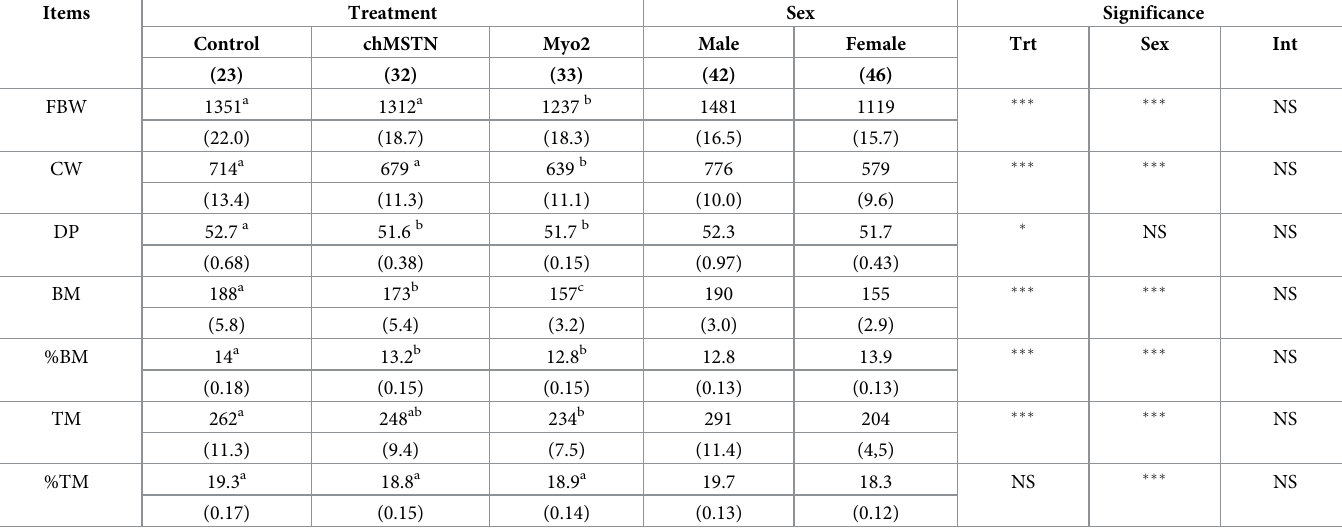
Table 4. Carcass characteristics of chicks from control, chMSTN, and Myo2groups in Experiment 2.